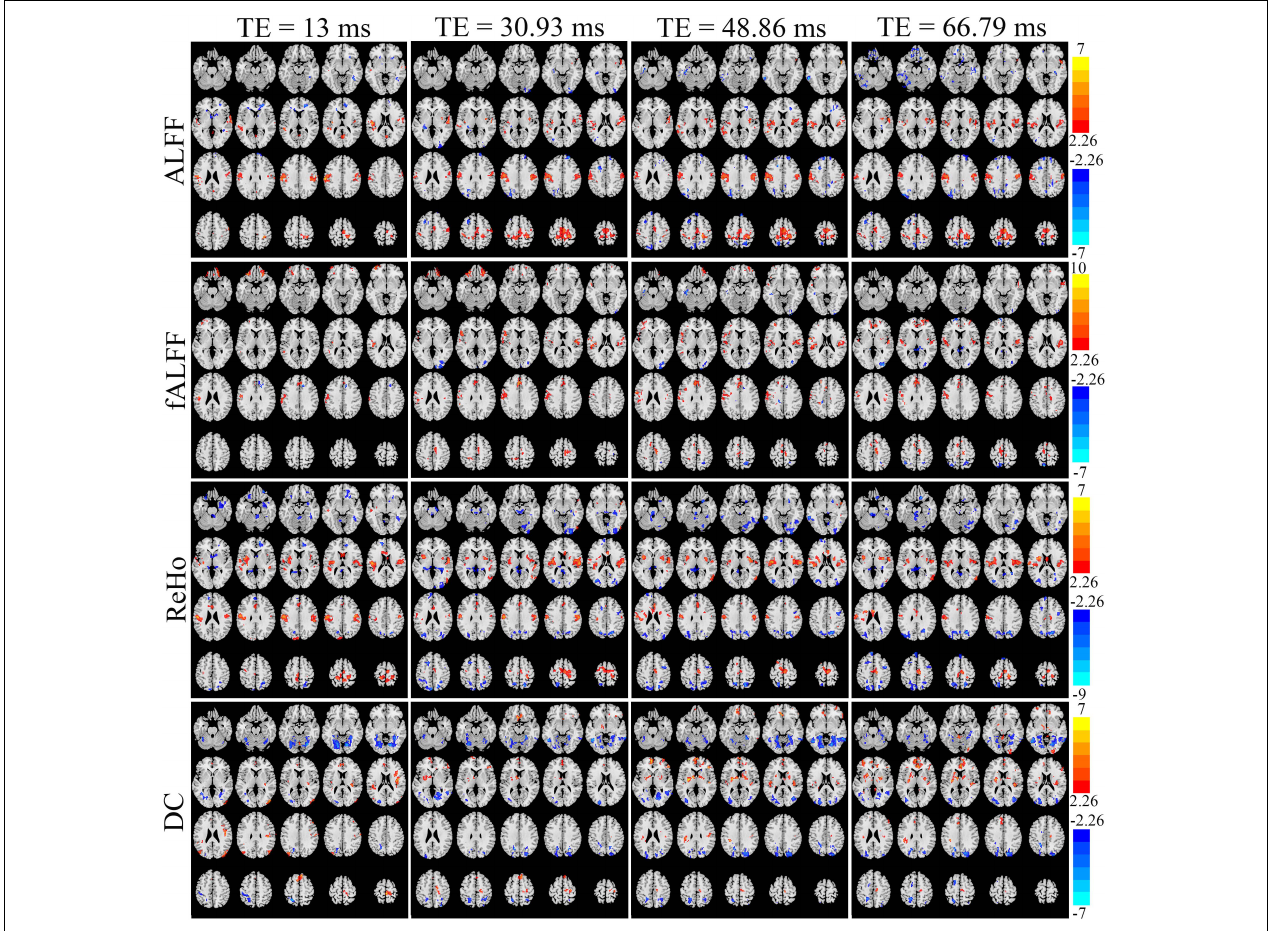
FIGURE 6 | The paired T maps between EO and EC of ALFF, fALFF, ReHo, and DC from four different TE datasets. EO, eyes open; EC, eyes closed; ALFF, amplitude of low-frequency fluctuation; fALFF, fractional ALFF; ReHo, regional homogeneity; DC, degree